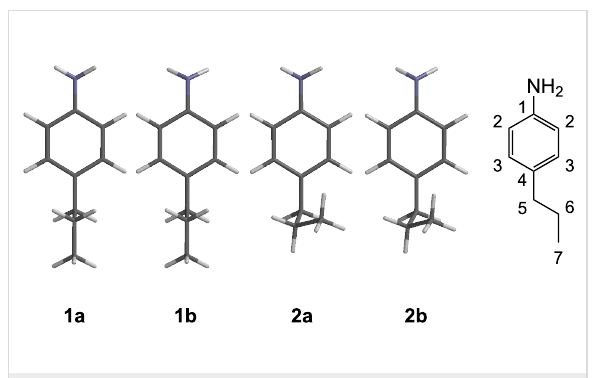
Figure 1: Four low energy conformations of 4-propylaniline obtained from B3LYP/6-31G* conformational search and labelled 2D structure ( 1a / 2a differ from 1b / 2b in the pyramidalization at the amine nitrogen, see main text for